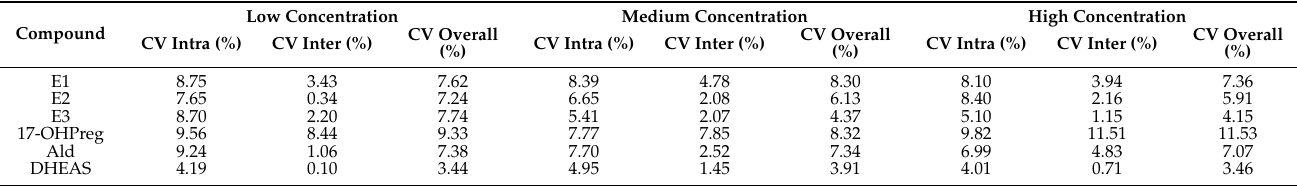
Table 5. Within-run and between-run CVs of different